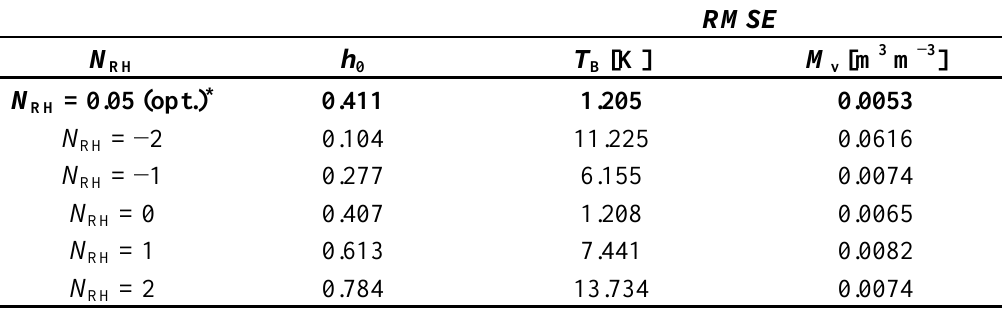
Table 2. h parameter inverted using multi angular H-polarized T 0 soil and assuming different N simultaneously inverted from the multi angular data.